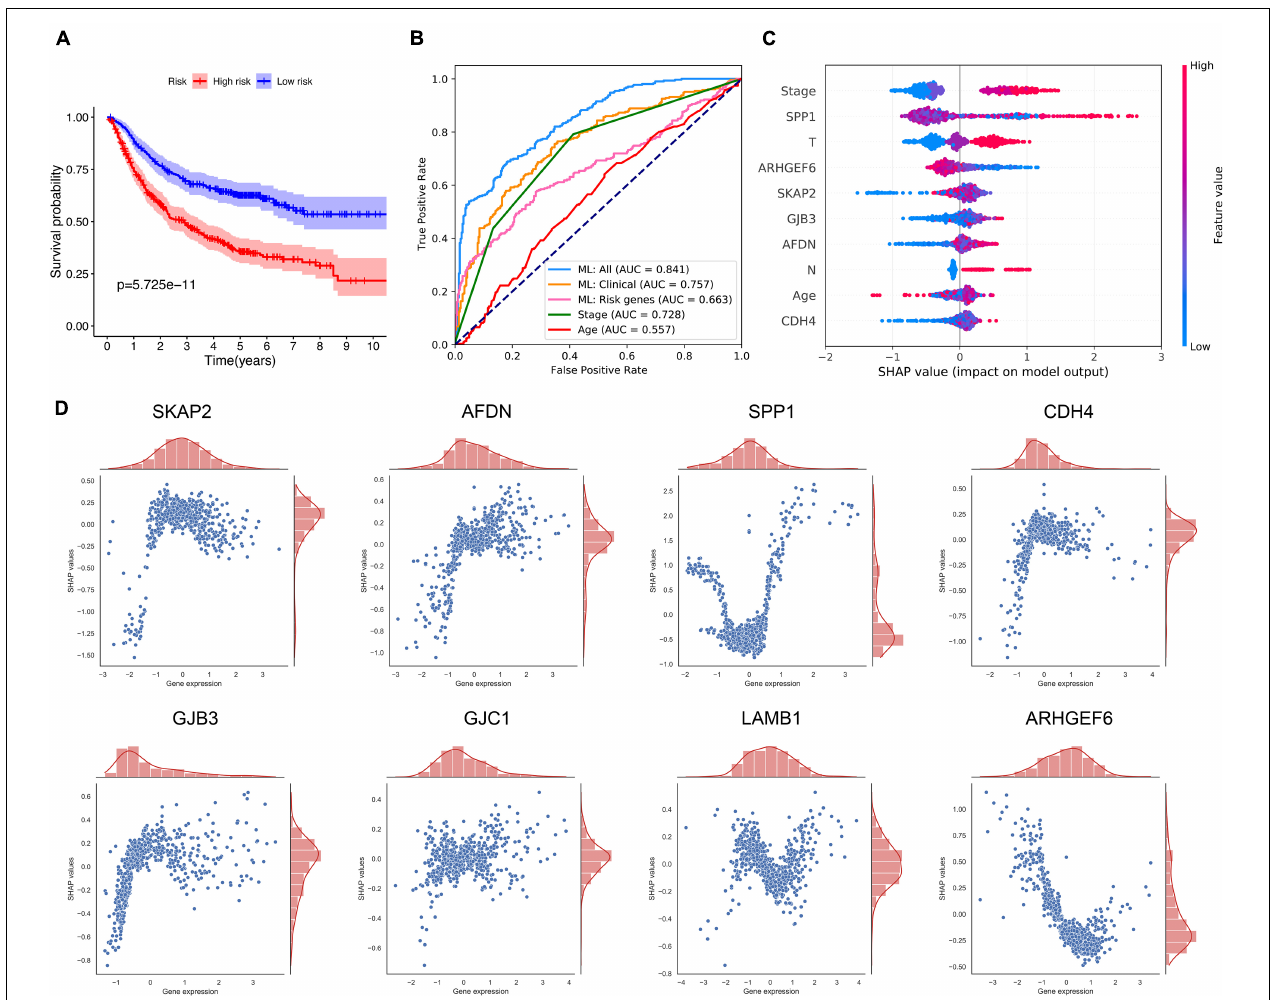
FIGURE 3 | Prediction of LUAD relapse by using machine learning. (A) The Kaplan–Meier curve for the comparison of the disease-free survival between the high- and the low-risk groups. (B) The receiver operator characteristic curves for the explored predictive models or methods. (C) SHAP values show the variable impacts on the prediction results of the model using all clinical information and eight ICAGs. (D) The distributions of the SHAP values for each ICAG on the model using all clinical information and the eight ICAGs. ML, machine learning; AUC, area under curves; SHAP, shapley additive